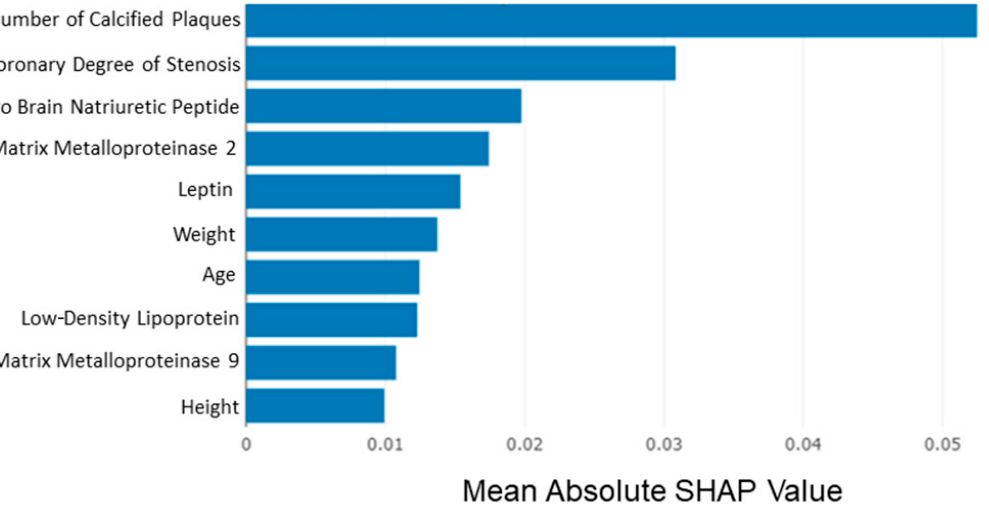
Figure 4. Feature importance based on mean SHAP values. The number of the existing calcified plaques and the highest coronary degree of stenosis are indicated as the most significant features.